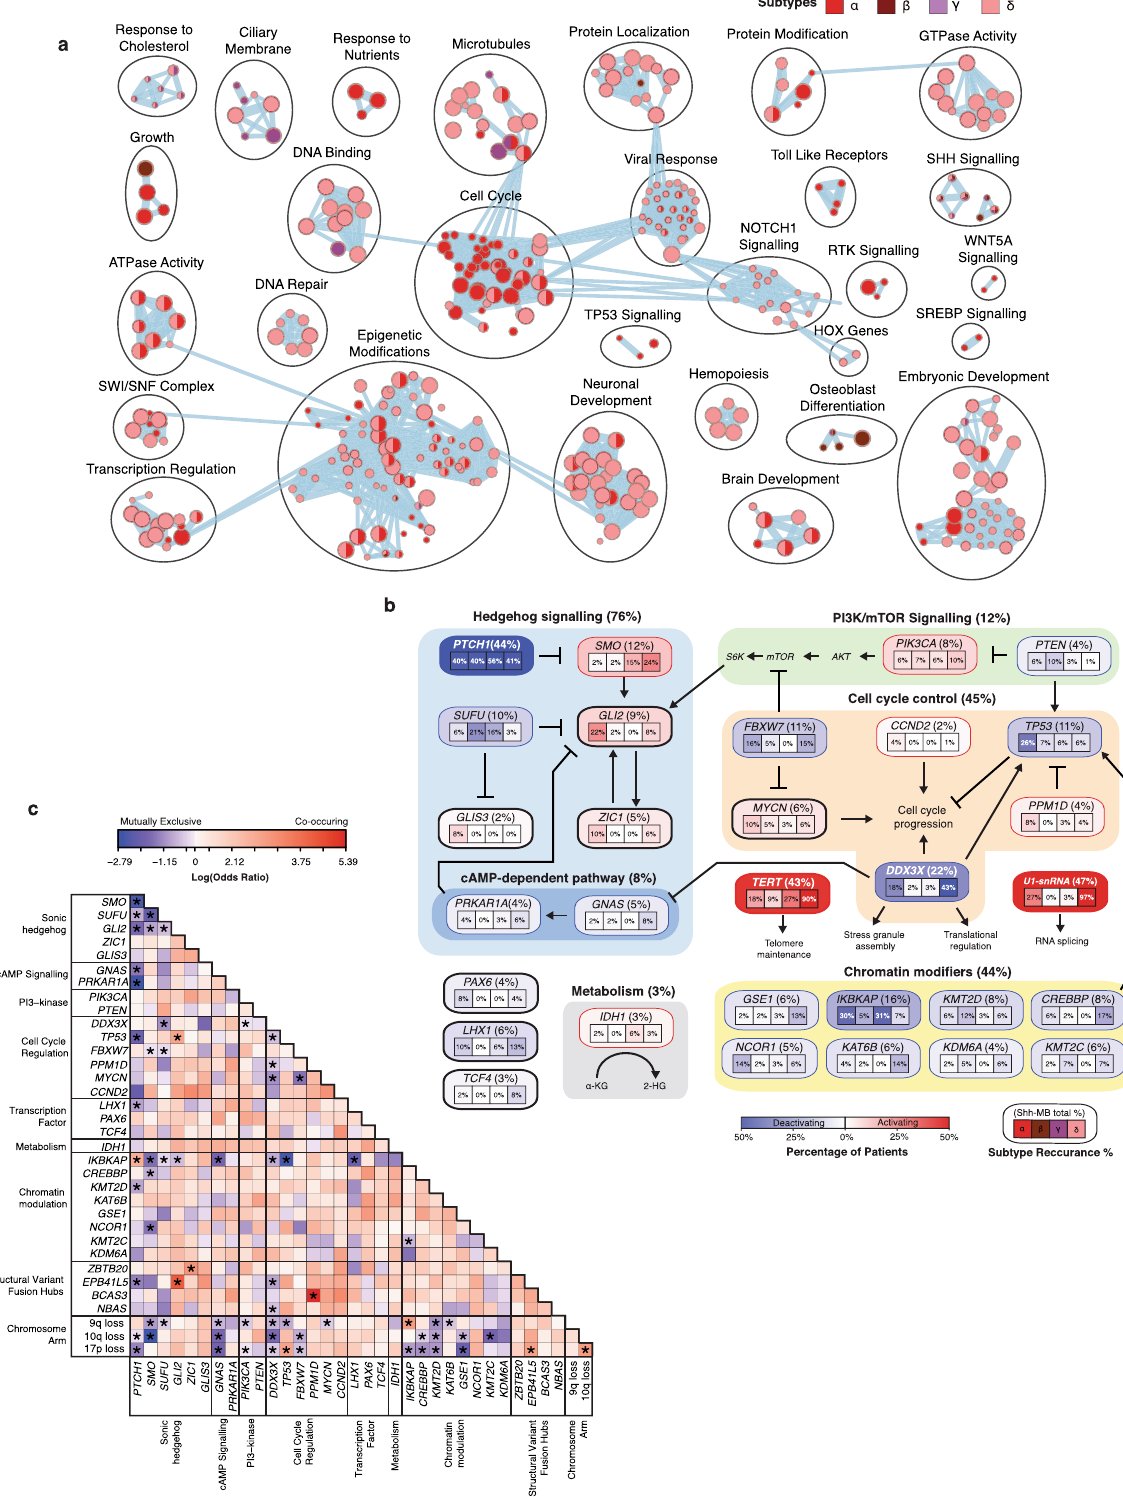
GNAS , DDX3X , and KMT2D . Furthermore, alterations in GNAS and PRKAR1A are mutually exclusive of PTCH1 further supporting its role in upregulating GLI2 through cAMP dependant signaling. Mutual exclusivity is also observed between MYCN and FBXW7 . We conclude that Shh-MB mutational events exhibit marked patterns of mutual